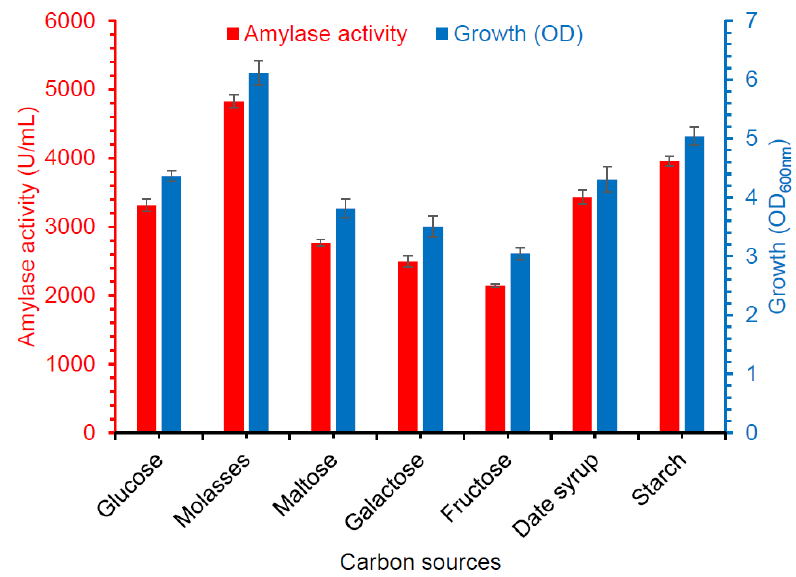
Figure 3. The effect of the carbon source (20 g/L initial concentration) on α -amylase production and Bacillus sp. BCC 021-50 growth at 37 ◦ C, initial pH of 7.0, for 60 h. The experiments were performed in triplicate and the data presented in the figure are the average of three parallel experiments. Error bars are shown for standard deviation.